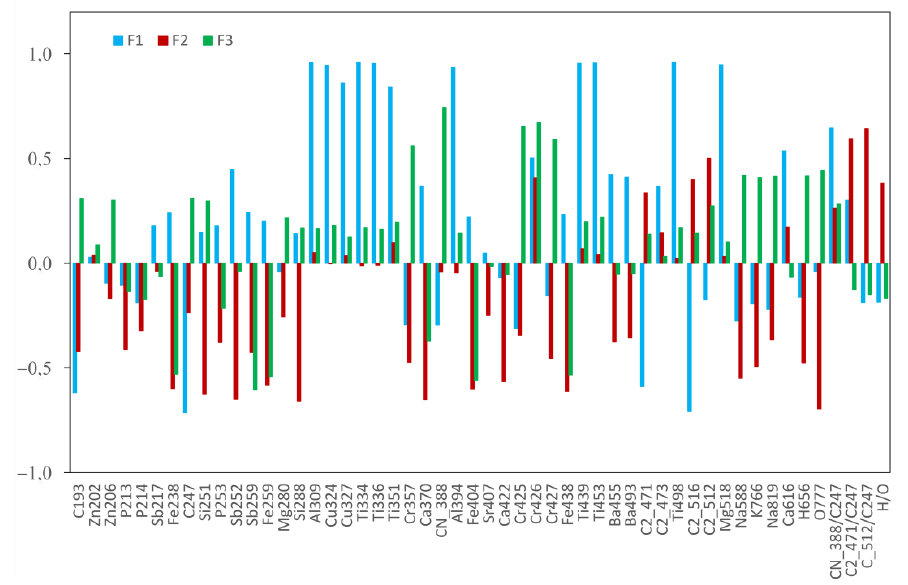
Figure 8. Factor pattern realized from the lines shown on Table 2. According to the factor pattern of F2, F2 is positively correlated with the molecular ratios C2/C ratio but also with the C2 intensity, both the C2 512 nm and C2 471 nm molec- ular bands and H/O. This factor mainly contains the polymeric aspect of the sample. As expected, the polymers are well separated from leathers along axis F2, as seen from the 3D graph. Polymers and leather group B are also well separated in F2. The F2 factor was negatively correlated with line intensity from Si, Fe, Na, and K. The leather LowT group and HighR groups are separated in F3. The three leather groups are also well separated in F3 from synthetics and polymers having negative F3, whereas the leather had a positive F3. The F3 reflects a high positive correlation with Cr, Na, K, and CN, and negative values for C2/C and H/O ratios. The factor analysis could correctly isolate 90% of the synthetic leather; only one sam- ple is misidentified as a polymer and three sheep leathers appeared as outliers. The score for polymer identification is 98%, and, with regard to the leather groups, LowT contained both the Cr and vegetable tanning samples as no special weigh was given to the Cr inten- sity. The exotic leathers are present in this group; the levels of Cr or other elements were lower in these samples. The Ti-tanned and iron-containing leathers were present in the HighR group. As mentioned in the discussion, the factor analysis revealed a discrimina- tion from the complexity of the spectra and not on the nature of the tanning process. Fur- ther study using a wider selection of vegetable tanned leathers should be performed in order to improve separation using the LIBS spectral information. 4. Conclusions In this study, a new method was employed for the separation of leather, synthetic leather, and polymer according to their LIBS spectra. Factor analysis is a convenient way to identify the main information responsible for the clustering of studied samples. The influence of the tanning process is clearly important and is clearly identified using the LIBS spectra. It was demonstrated that separation of synthetic leather from other samples was possible. Factor analysis was sensitive to the complexity of the spectra produced when high amounts of pigments or tanning agents are employed. The molecular infor- mation and ratios were also efficient at identifying and discriminating between polymers or synthetic leather from other samples.